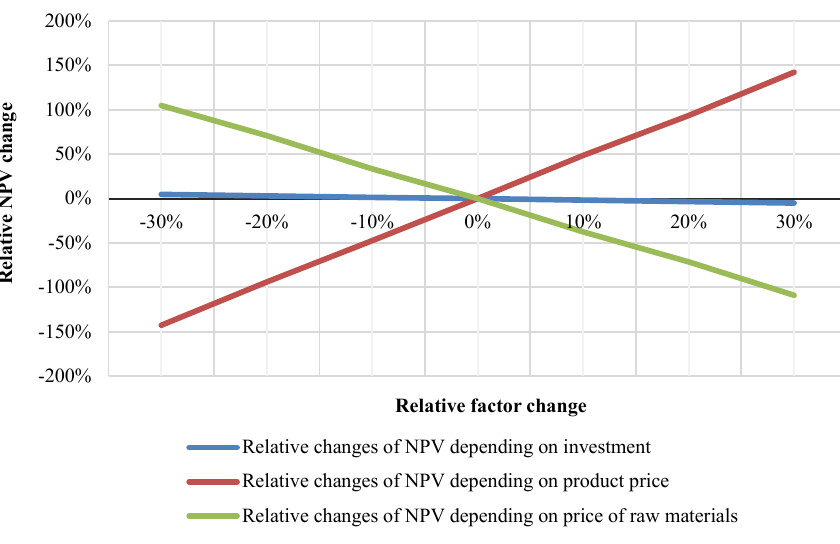
Fig. 2. Relative changes of company with